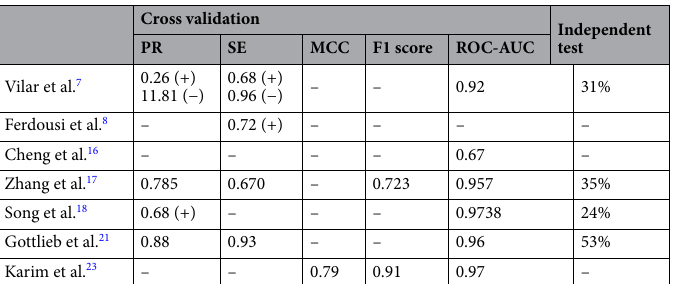
Table 2. Performance comparisons with existing methods. The bracketed sign + denotes positive class, the bracketed sign − denotes negative class and the other sign – denotes missing